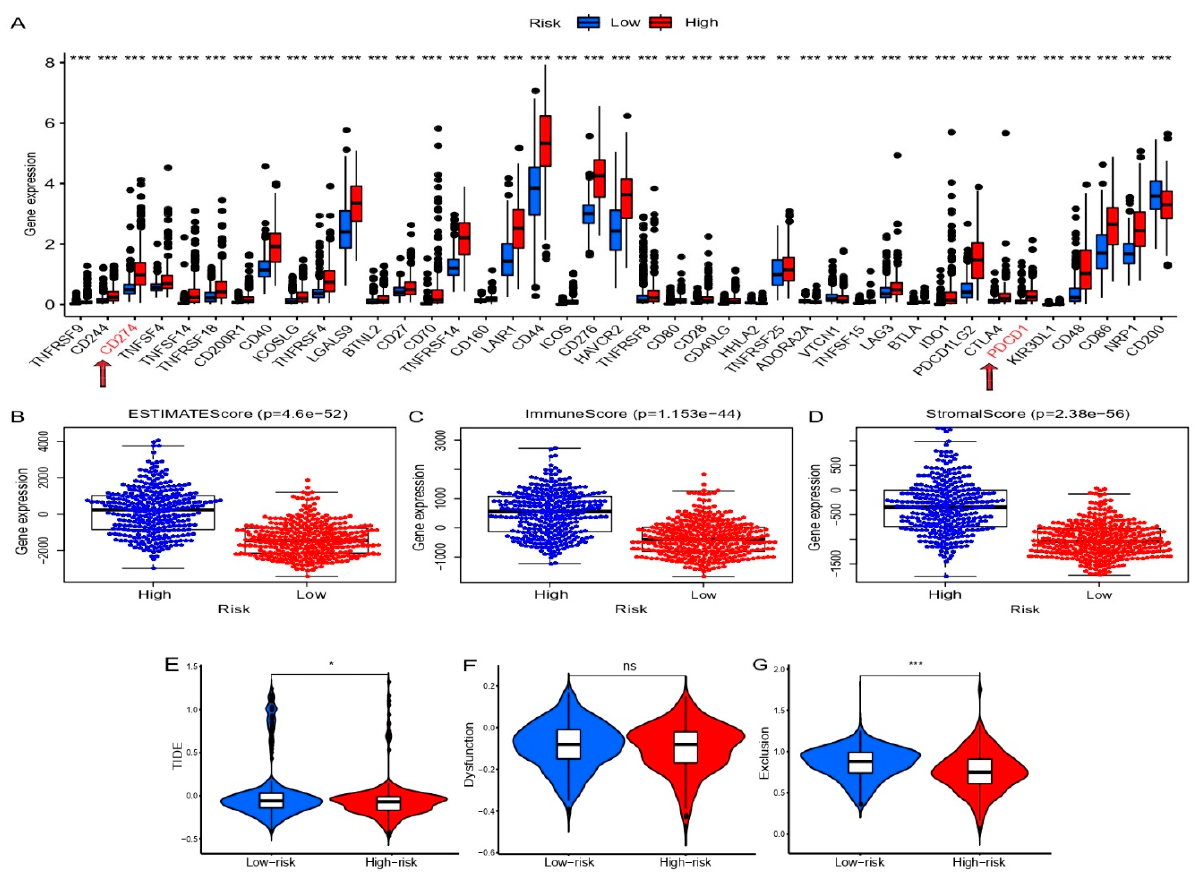
Figure 7. Comparison of immune checkpoint expression levels ( A ), scores for glioma microenviron- ment ( B – D ), and correlation analysis between TIDE evaluation ( E – G ) in TCGA dataset between high- and low-risk groups. TIDE, tumor immune dysfunction and exclusion; TCGA, The Cancer Genome Atlas. * p < 0.05, ** p < 0.01, *** p < 0.001, ns, no significance.